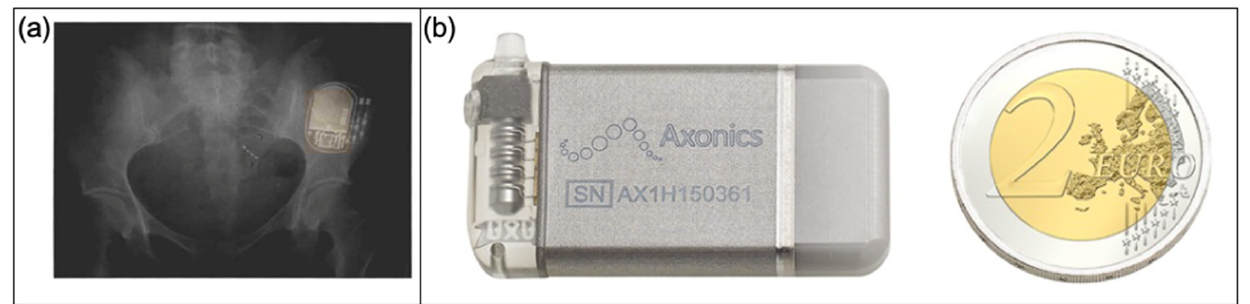
Figure 3. Nerve stimulation devices. ( a ) An anterior–posterior radiograph showing the InterStim device in upper buttock, with a lead electrode in sacral vertebrae (S4) foramen [40]; ( b ) the Axonics neurostimulator device next to a coin [84]. Copyright 2018, John Wiley and